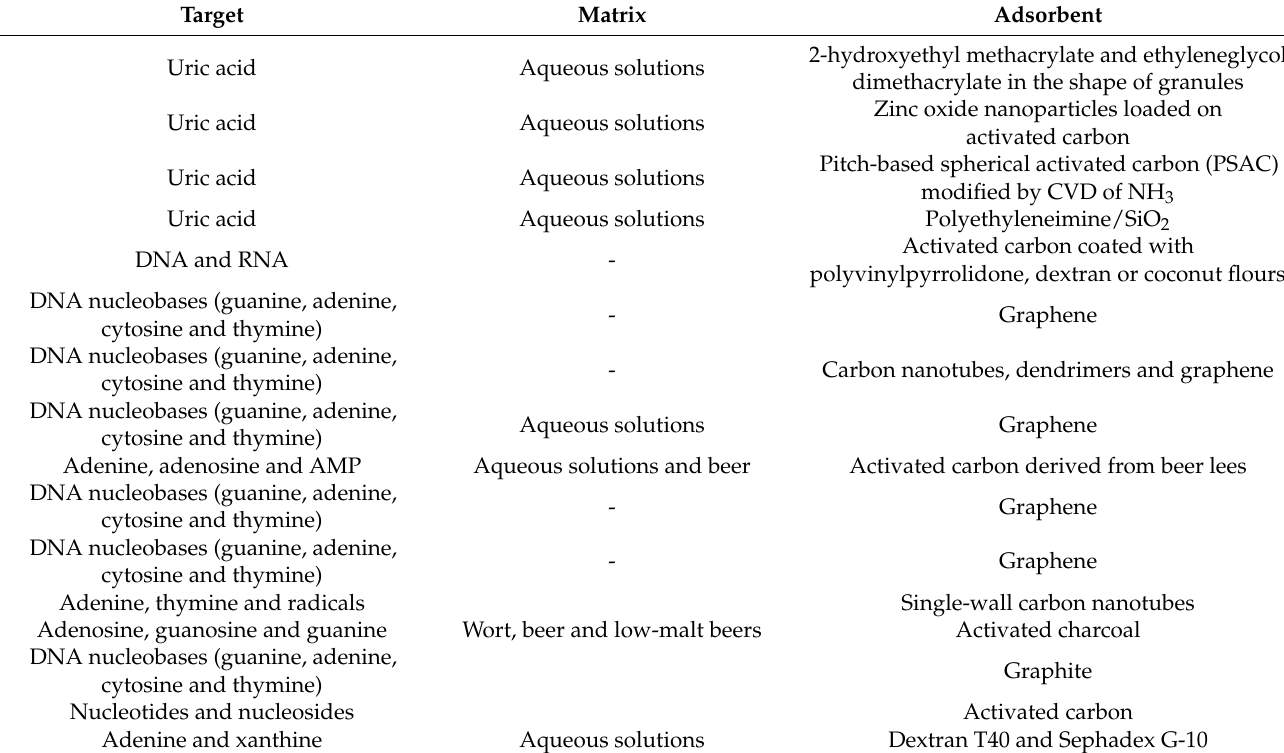
Table 6. Adsorption of purines and close